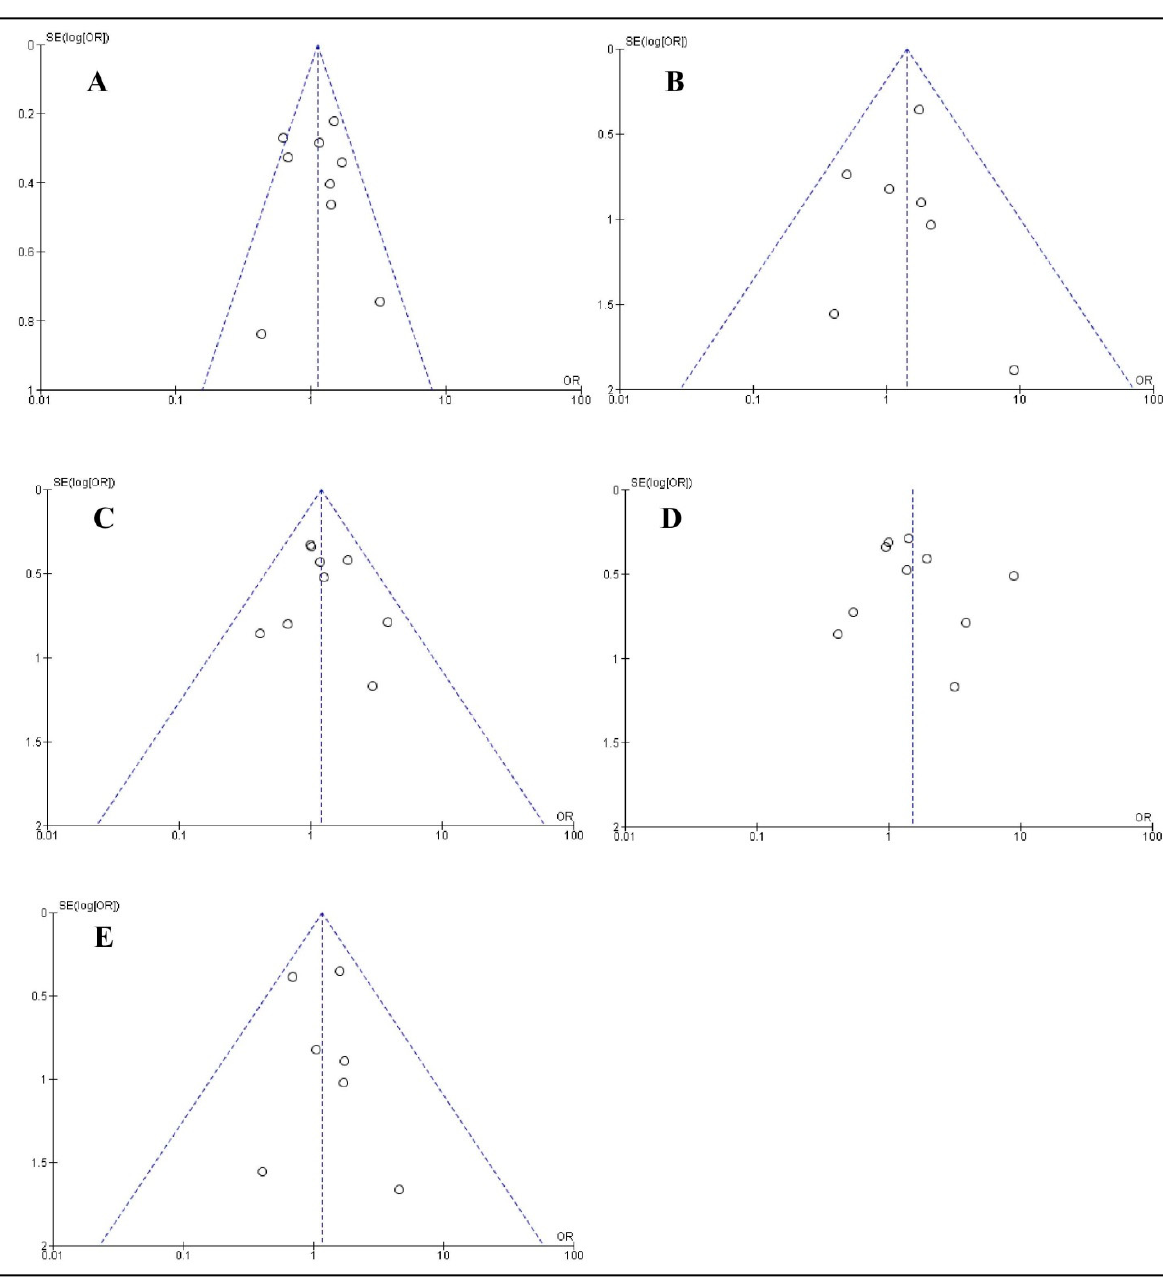
Figure 3. Funnel plot analyses of five genetic models for the association between TNF- α ( − 308 G > A) polymorphism and peri-implant disease risk: ( A ) allelic, ( B ) homozygous, ( C ) heterozygous, ( D ) recessive, and ( E ) dominant.